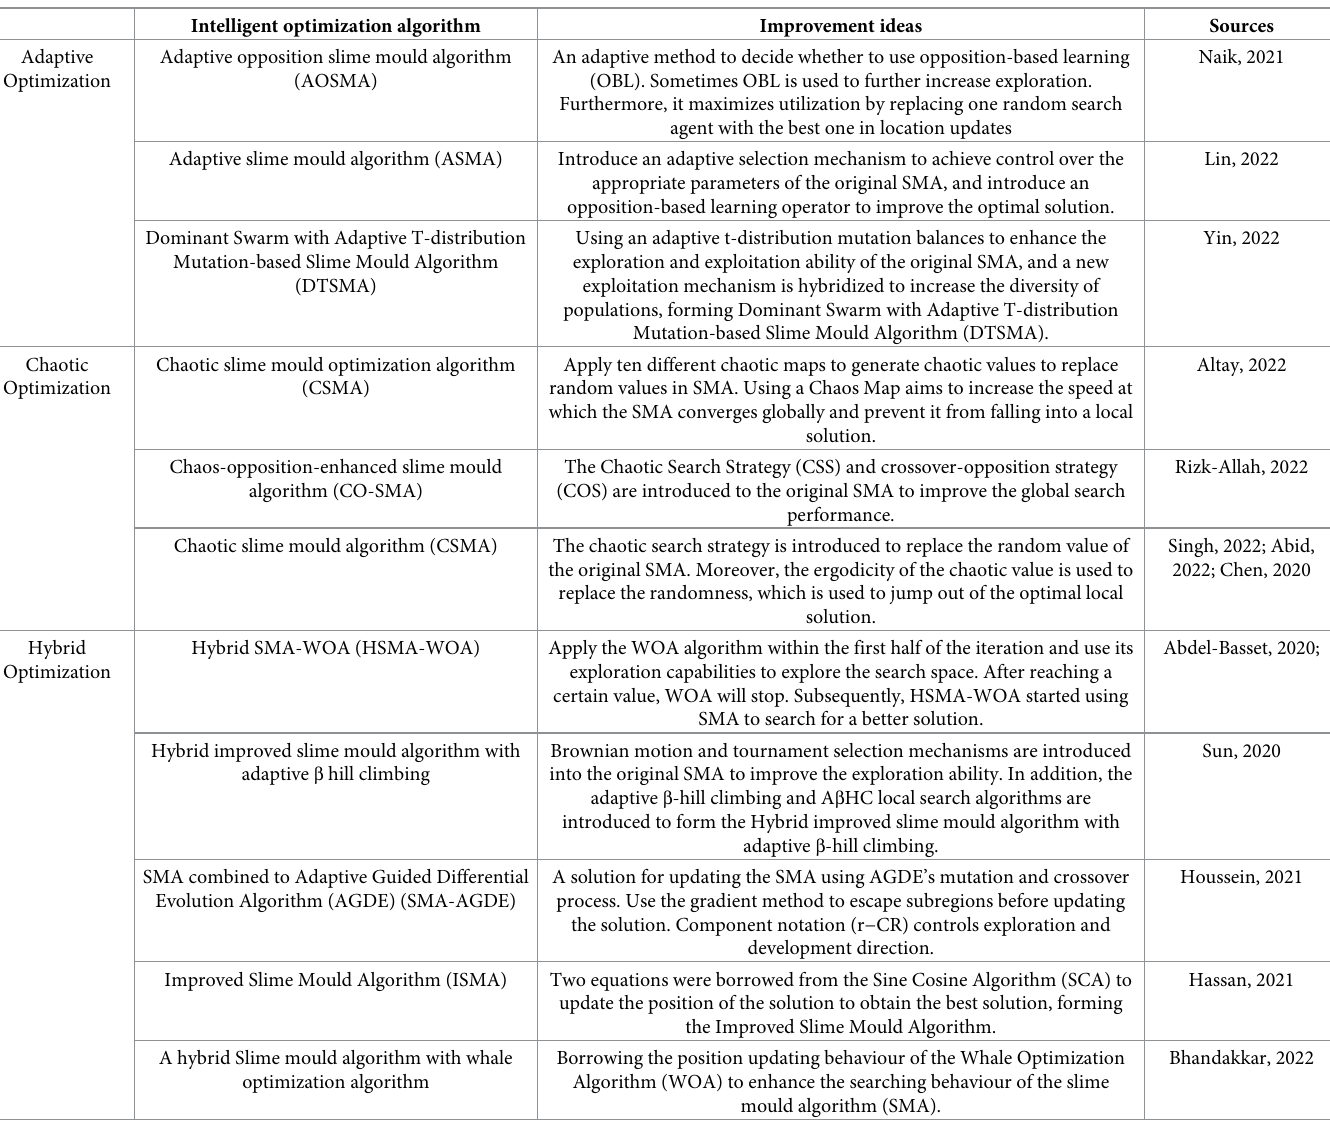
Table 1. A summary of some improved variants of the slime mold algorithm, including their names, improvement ideas, and the source of the